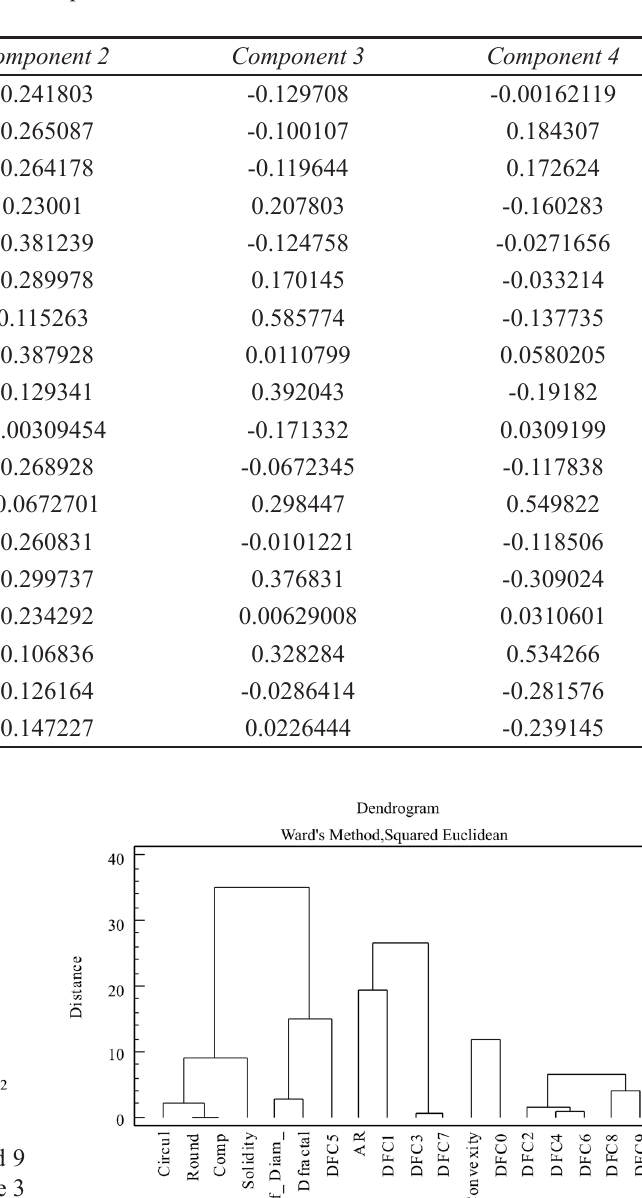
TABLE III - Weight of individual descriptors for the 4 principal components